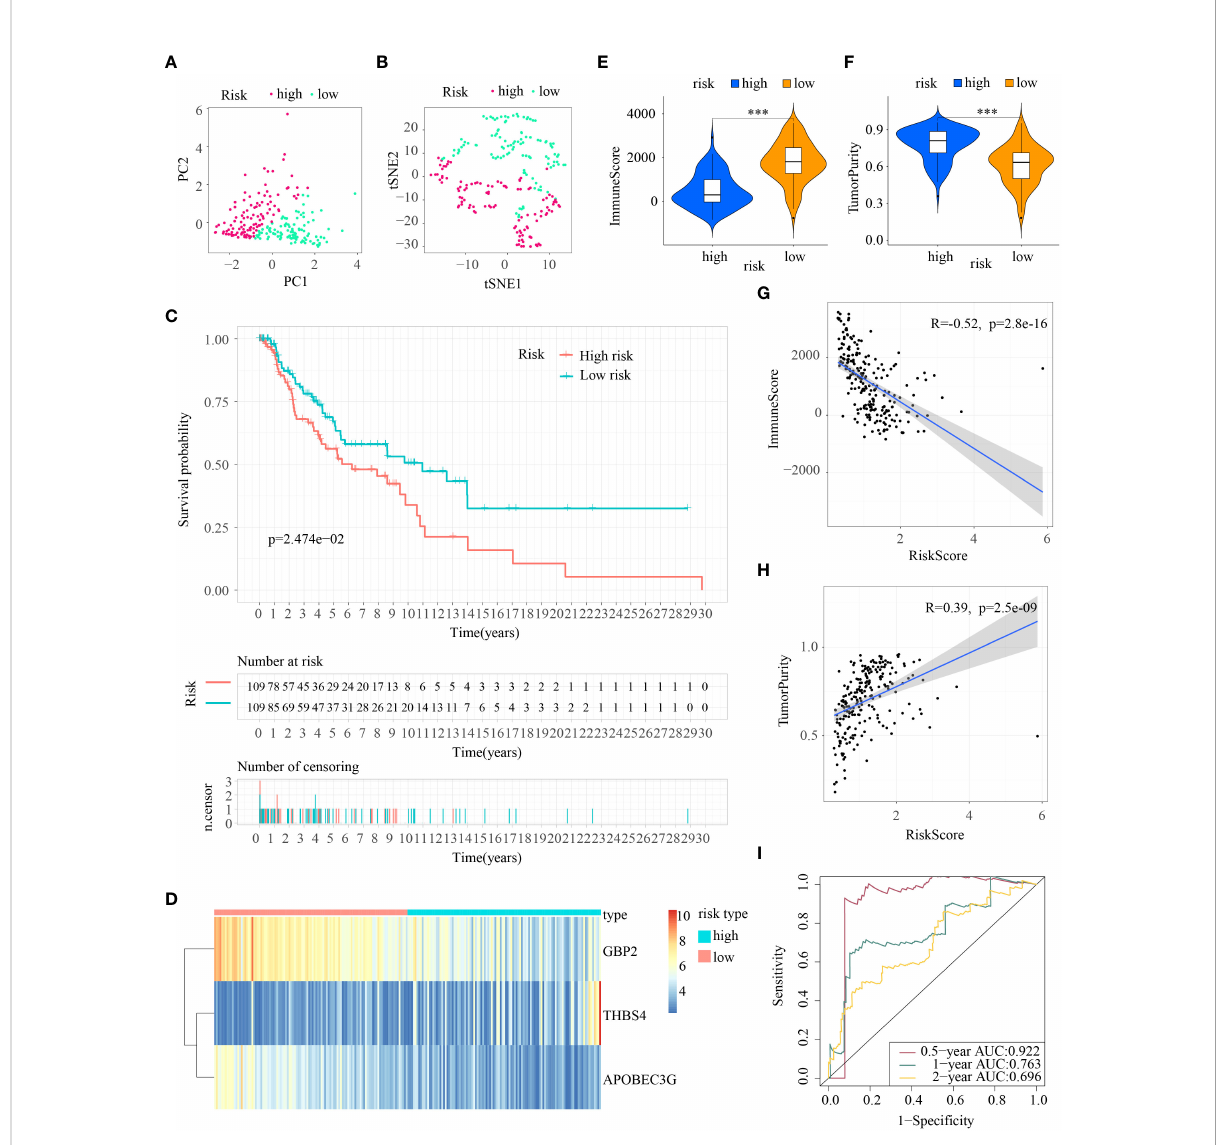
FIGURE 4 Construction of ICDRS in the train cohort. (A, B) PCA and t-SNE analysis illustrated an excellent clustering performance of the ICDRS-based risk score; (C) Kaplan – Meier survival curves for the overall survival of two risk groups in the train cohort; (D) Distribution pattern of the expression levels of the 3 genes in the train cohort; (E, F) Comparing TME components in train cohort (*** indicates p < 0.001); (G) The correlation between ImmuneScore and risk score; (H) The correlation between TumorPurity and risk score; (I) AUC values of ROC curves in the train